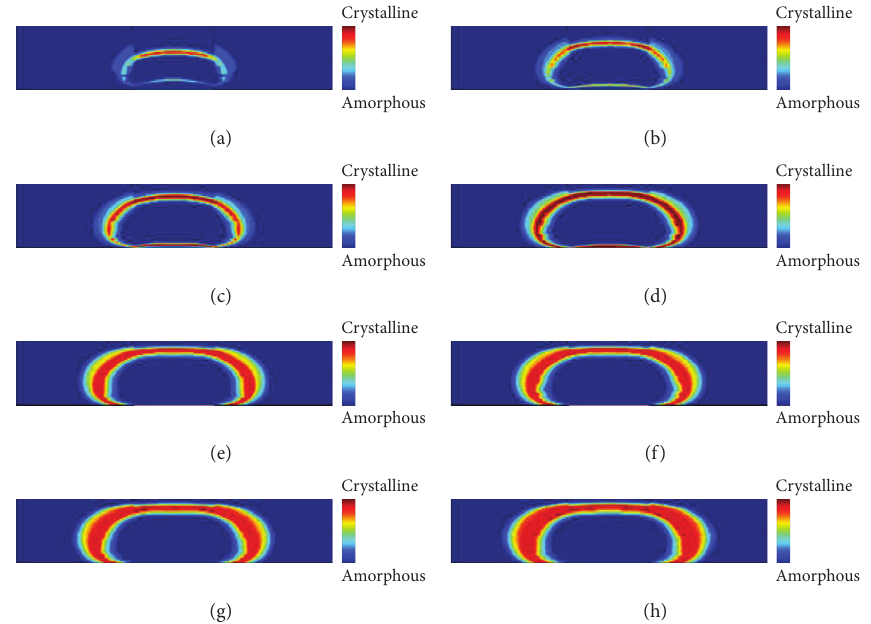
Figure 13: Phase distribution of simulation 4. (a–h) The phase distribution of GST after imposing 2, 3, 4, 6, 9, 10, 12, and 15 continuous pulses on the resistance change unit,